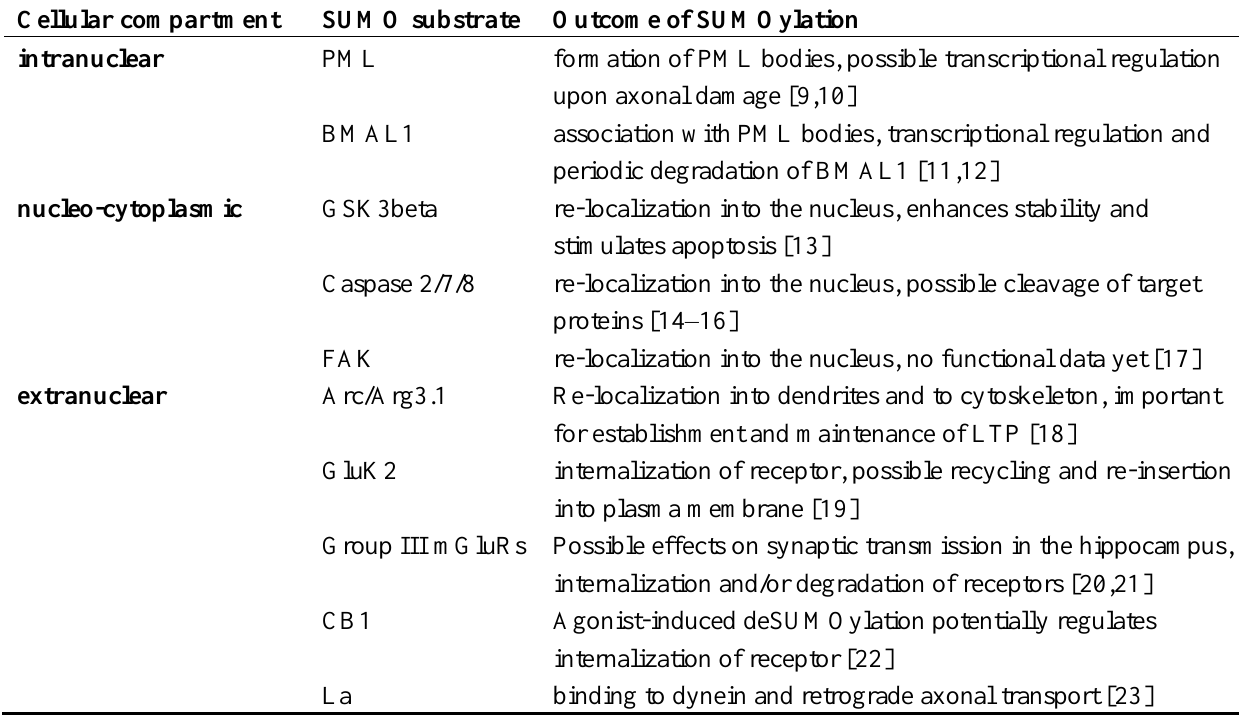
Table 1. Consequences of SUMOylation of proteins of different cell